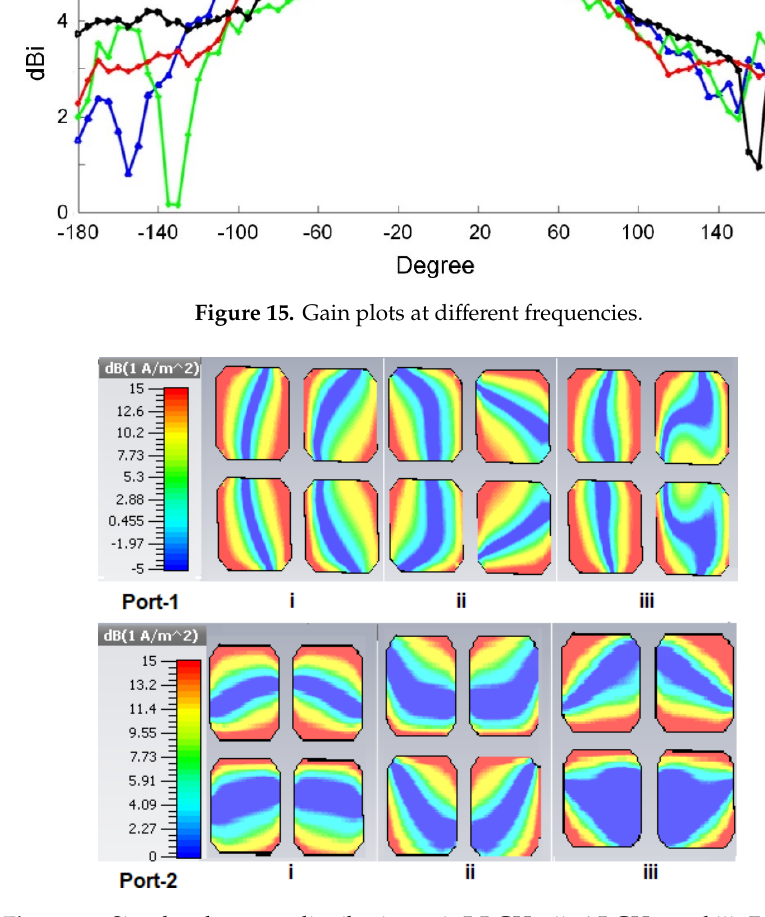
Figure 16. Simulated current distribution at i. 5.5 GHz, ii. 6.5 GHz, and iii. 7.5 GHz.